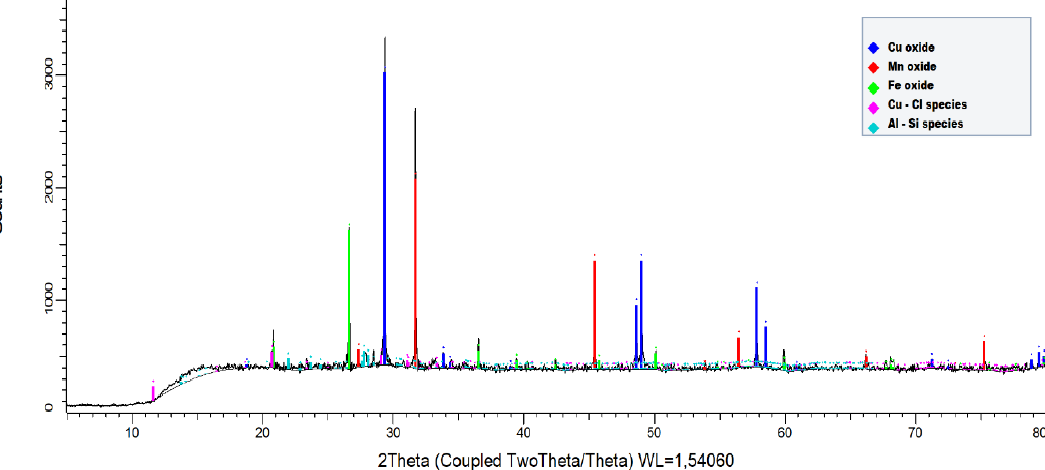
Figure 5. X-ray di ff ractogram for solid residue (black copper ore) after being leached at 25 ◦ C with Figure 5. X-ray diffractogram for solid residue (black copper ore) after being leached at 25 °C with NaCl and FeSO 4 in a time of 70 NaCl and FeSO 4 in a time of 70 min.